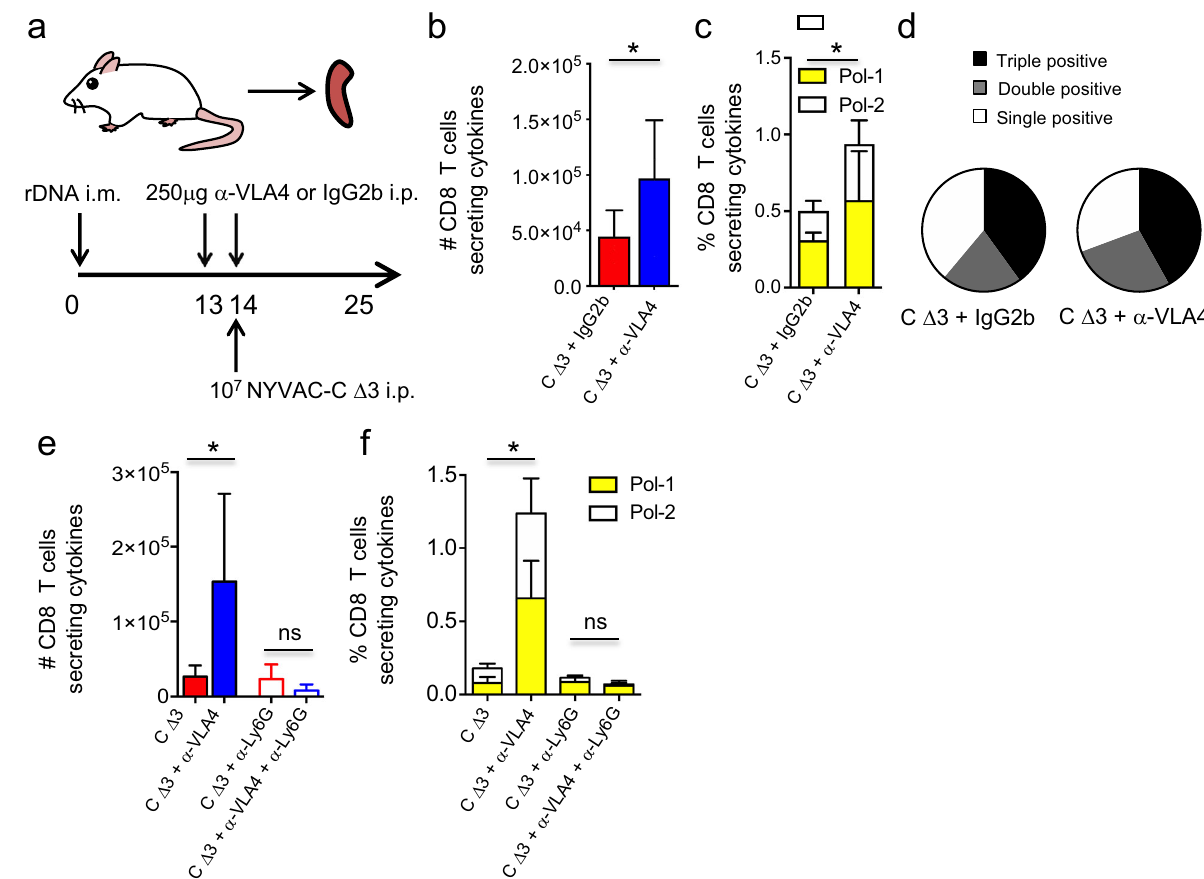
Fig. 6 Inhibition of VLA-4 increases HIV-speci fi c T-cell responses. Vaccine-induced HIV-1 – speci fi c CD8 T-cell response from spleen of mice ( n = 4 per group) primed intramuscularly with recombinant DNA, infected with 10 7 PFUs of NYVAC-C Δ 3 and injected with IgG2b isotype or anti-VLA4 antibody 16 h before and 1 h post infection ( a ). The response was measured 11 days after the last immunization, after splenocyte stimulation with HIV-1 Pol-1/Pol-2 peptides. Total numbers ( b ) or percentages of Pol-1-, Pol-2-speci fi c ( c ) CD8 T cells that express IFN- γ and/or TNF and/or CD107a. Nonspeci fi c responses of mice infected with control NYVAC-WT were subtracted from the total value. Graphs show mean ± SD. Pie chart colors indicate the relative percentage of cells producing three (black), two (gray), or one (white) activation markers ( d ). Total numbers ( e ) or percentages of Pol-1-, Pol-2-speci fi c ( f ) CD8 T cells that express IFN- γ and/or TNF and/or CD107a in mice infected with 10 7 PFUs of NYVAC-C Δ 3, injected with IgG2b isotype or anti-VLA4 and treated or untreated with anti-Ly6G. * P < Peptides (pcDNA) by the intramuscular route 22 . Plasmids were puri fi ed using Endofree Plasmid Mega Kit (Qiagen). After two weeks, mice were The HIV-1 peptides Pol-1 (LVGPTPVNI) and Pol-2 (YYDPSKDLI) are H-2 d - immunized i.p. with 10 7 PFU of NYVAC-WT, NYVAC-C, or NYVAC-C Δ 3. restricted CTL epitopes 23 and were provided by the CNB-CSIC Proteomics Mice immunized with sham DNA- ϕ prime and NYVAC-WT boost were used Service. 4 antibody (PS/2, BioXcell) or IgG2b, κ isotype control antibody (LTF-2, Flow cytometry BioXcell) were injected intraperitoneally (250 μ g per mouse) on day 13 (16 h before infection) and on day 14 (1h after infection). Animal studies were approved by the Ethical Committee of Animal Experimentation (CEEA-CNB) of the Centro Nacional de Biotecnologia (CNB-CSIC, Madrid, Spain) and by Institutional Committee of the Cantonal Veterinary (Commissione cantonale per gli esperimenti sugli animali, Ticino), in accordance with national and international guidelines and the Royal Decree (RD 1201/2005) (permit n° 12013, 13013) and with the Swiss Federal Veterinary Of fi ce guidelines (permit n° TI28/17, TI02/14, and TI07/13). Cell and viruses stained for surface markers with anti-CD3 (145-2C11), -CD4 (GK1.5), and African green monkey kidney cells (BSC-40; American Type Culture -CD8 (53-6.7) (all from BD), fi xed, permeabilized (Cyto fi x/Cytoperm kit; BD), Collection) and primary chicken embryo fi broblast (CEF) cells from and stained intracellularly with anti-IFN- γ (XMG 1.2) and -TNF (MP6-X722) fertilized eggs (MSD Animal Health, Salamanca, Spain) were grown in (all from BD). Cells were acquired using a GALLIOS (Beckman Coulter) or DMEM supplemented with 10% (vol/vol) FCS. All viruses were grown in LSRII (BD) fl ow cytometer and data were analyzed with FlowJo software primary CEF cells, puri fi ed through two 36% (w/v) sucrose cushions, and titrated by immunostaining plaque assay in BSC-40 cells as described 47 . v.9.9.5 and 10.5.3.